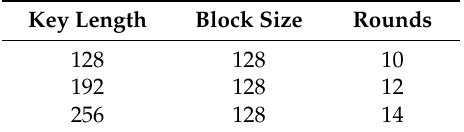
Table 1. Advanced Encryption Standard (AES) core parameters. Key